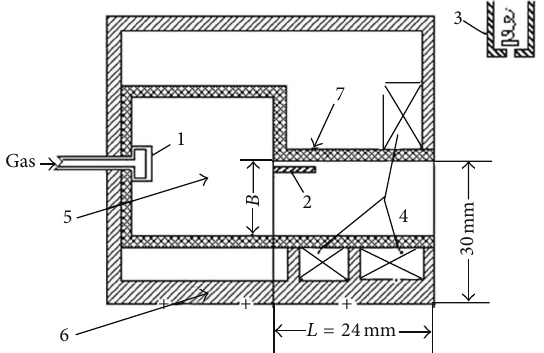
Figure 1: Schematic view of the ATON A-3 SPT: (1) gas distributor, (2) anode, (3) cathode-compensator, (4) magnetic coils, (5) buffer volume, (6) magnetic circuit, and (7) dielectric channel; 𝐵 = 12